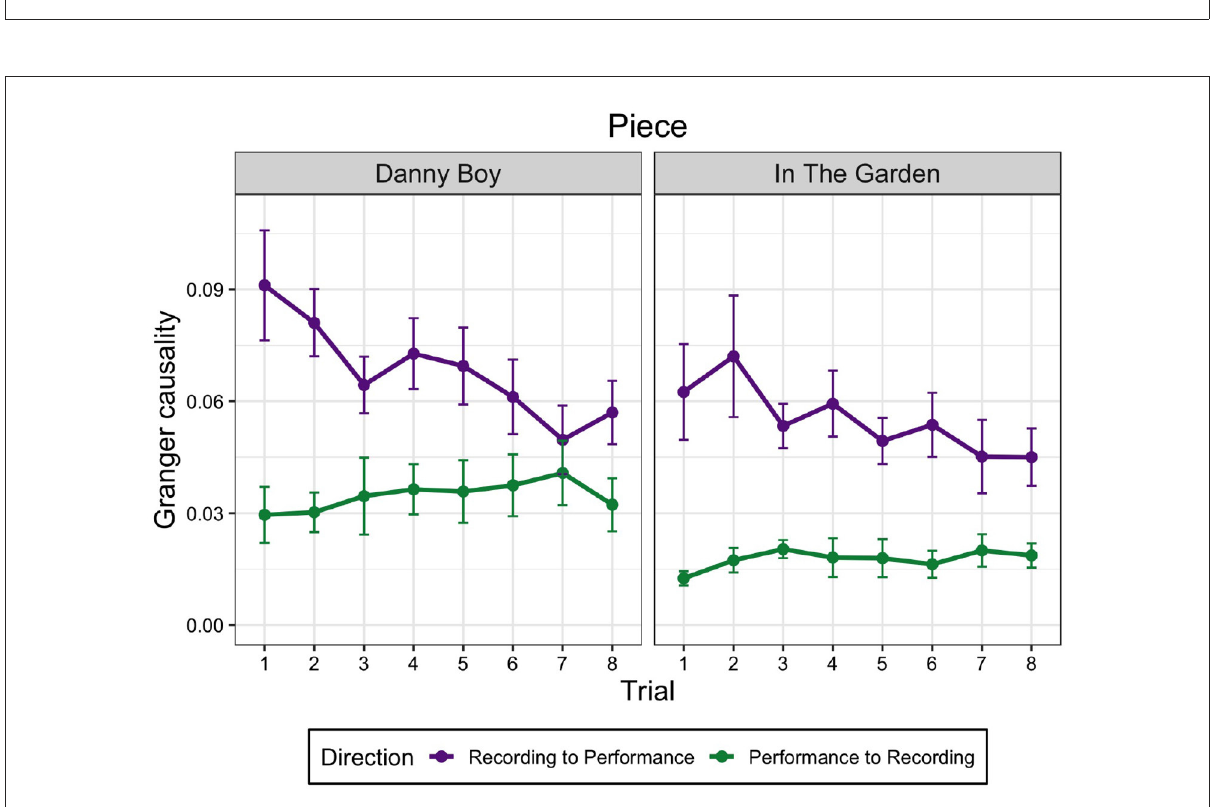
FIGURE3 Granger causality (GC) values in both directions for each piece separately across the eight trials. Error bars represent standard